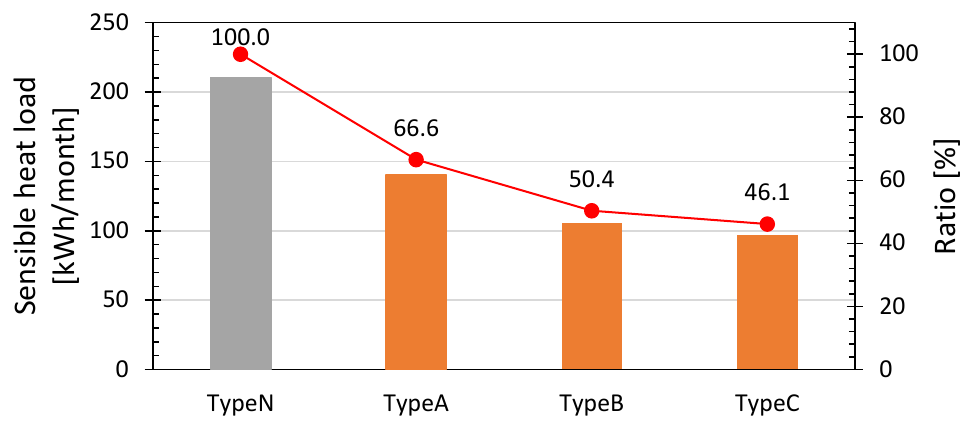
Figure 10. Comparison of sensible heat load by type (living room, February).